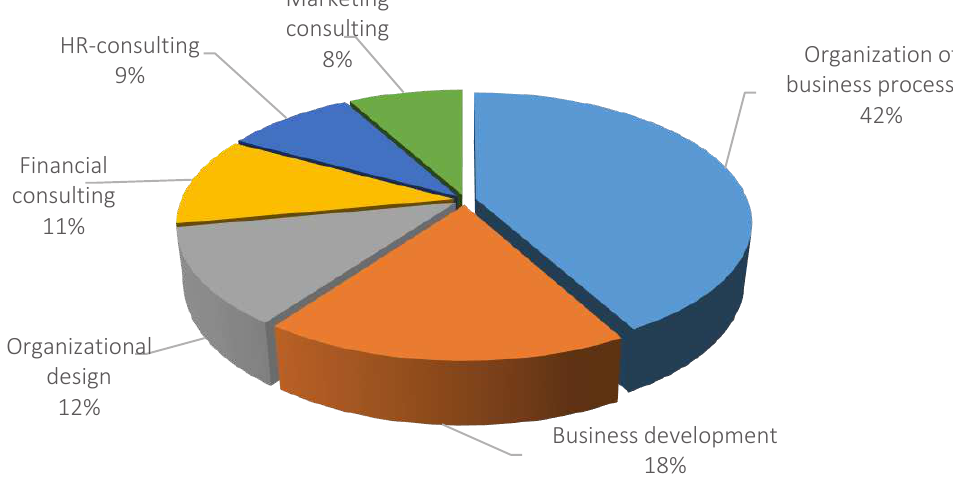
Figure 6. Structural analysis of consulting